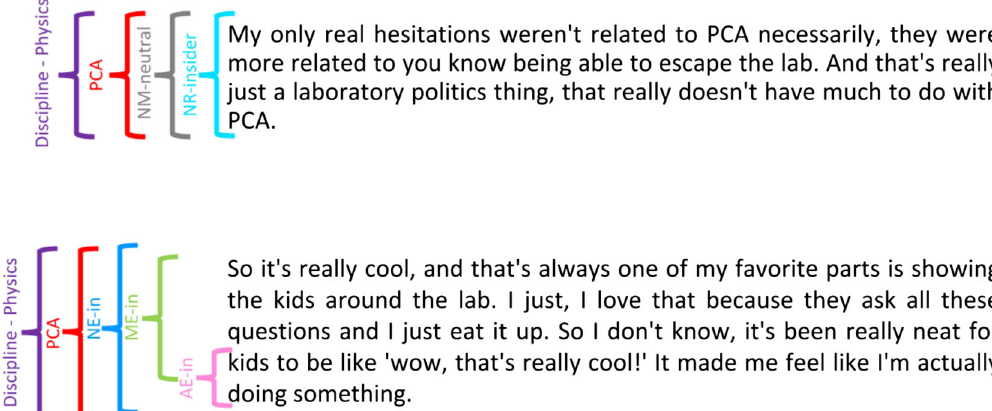
FIG. 6. Example of coded segments from interviews. The top example shows that the text was coded as negotiation of the repertoire [(NR) community dimension code] and nexus of multimembership [(NM) mechanism of identity code] for both the physics and PCA communities. The bottom example shows the first sentence coded as mutuality of engagement (community dimension code) and the last sentences as accountability to the enterprise (community dimension code). The entire segment was coded as negotiated experiences (mechanism of identity code) for both the physics and PCA